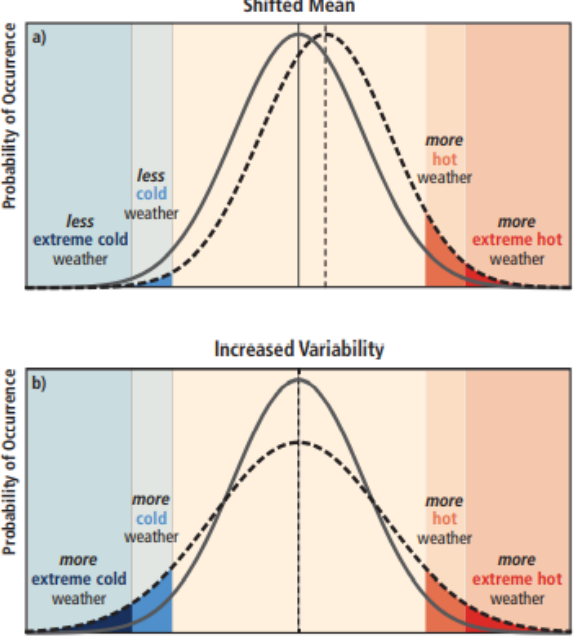
Figure 2. This probability density function captures the likelihood of specified events resulting from a given temperature distribution and its changes. As with any bell curve, those events that fall near the center are most likely, and events that occur in lower and upper temperature extremes have smaller probability. ( a ) a shift in the mean; ( b ) a shift in the varience [7]. Using this approach, marine heat waves were described for the Arctic during 1982 – 2020 using three criteria and three independently produced daily sea surface temperature (SST) products (Figure 3) [8]. The primary source was the NOAA DOISST v2.1 that is a global daily SST product with a resolution of 0.25° that blends in situ and bias-corrected advanced very high resolution radiometer (AVHRR) SST measurements. The criteria were (a) SST anomalies are higher than the 95th percentile threshold based on 1982 – 2011 period, and (b) the high anomalies are sustained for at least five consecutive days. Their analyses indicated that the intensity, duration, frequency, and areal coverage of Arctic marine heat waves increased during 1982 – 2020, and were greater in recent decades due to a warming climate. The maximum SST extremes are between 3 °C and 5 °C in the Barents Sea, Kara Sea, Laptev Sea, East Siberian Sea, Chukchi Sea, Beaufort Sea, and Baffin Bay, and between 3 °C and 4 °C in the Norwegian Sea and the Greenland Sea. These events were triggered in mid-July to early August from 1982 to 2020; they endured until mid-August during 1982 – 2000, until early September during 2000 – 2010, and until late September during 2010 – 2020.